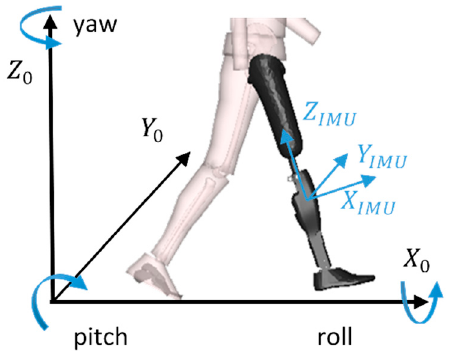
Figure 1. Definition of the inertial measurement unit (IMU) and global earth-fixed frames and representation of the three angles defining the orientation of the IMU relative to the global frame.